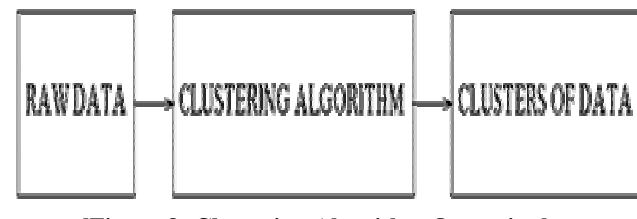
[Figure 8: Clustering Algorithm Operation] Types of Clustering